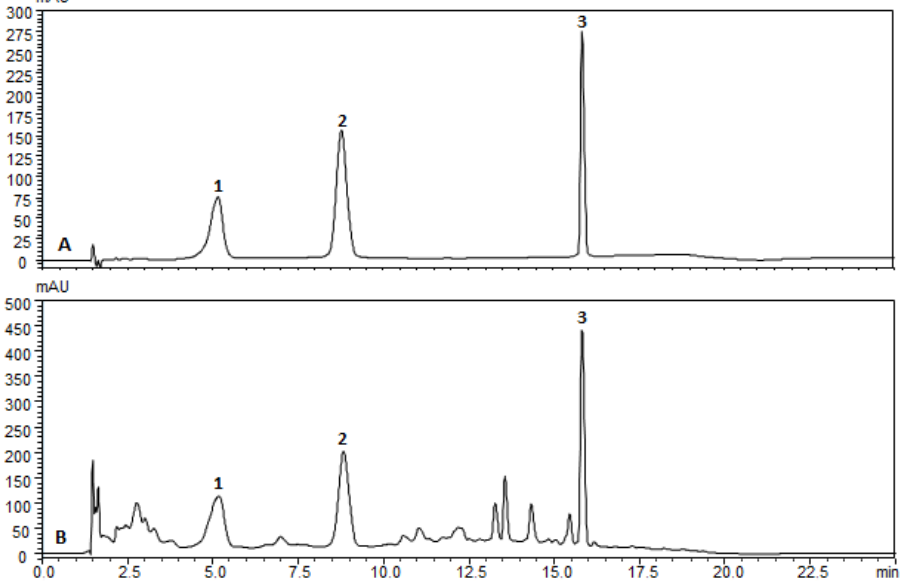
Figure 1. Punicalagin α (1), Punicalagin β (2), and Ellagic acid (3); ( A ) reference standards and ( B ) pomegranate peel extract fingerprint obtained by high-performance liquid chromatography according to the conditions presented in the methodology. Table 1. Mean (standard deviation) of the concentration of phenolic compounds (mg g − 1 ) in samples.